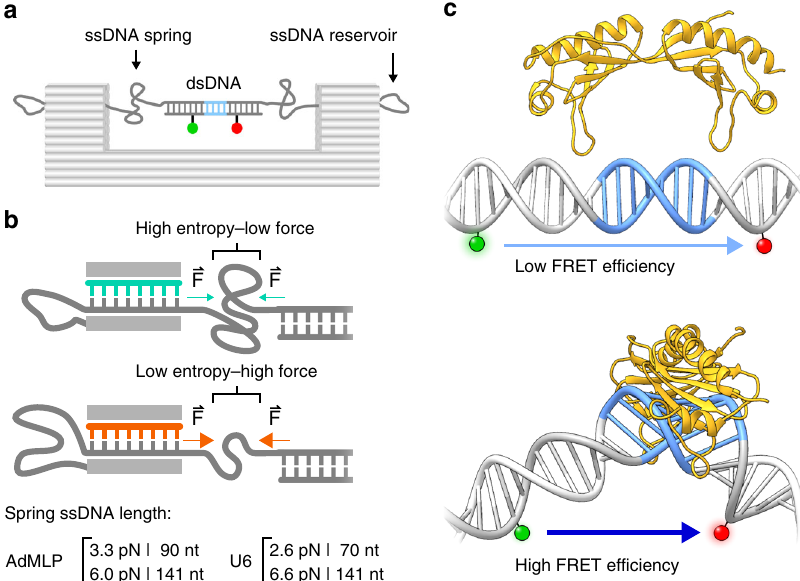
Fig. 1 DNA origami-based force clamp monitors TBP-induced DNA bending under force. a Schematic overview of the DNA origami force clamp. The ssDNA spring protrudes from the DNA origami body and spans the 43 nm gap of the rigid DNA origami clamp body (grey). Centred within the ssDNA spring is a double-stranded promoter region including the TATA-box element (blue) fl anked by a donor/acceptor (green/red) fl uorescent dye pair for FRET sensing. b The ssDNA spring length can be adjusted with DNA from the reservoir by using different staple strands (teal/orange) during assembly. Reducing the number of nucleotides spanning the gap leads to a smaller number of adoptable conformations of the ssDNA chain and thus results in a higher entropic force. The length of the ssDNA spring for low (AdMLP: 3.3 pN/U6 promoter: 2.6 pN) and high forces (AdMLP: 6.0 pN/U6 promoter: 6.6 pN) is shown. c Single-pair FRET assay as readout for the bending of promoter DNA by the TATA-binding protein (TBP, yellow). A donor (ATTO 532, green) and acceptor fl uorophore (ATTO 647 N, red) fl ank the TATA-box element (blue), resulting in a low ef fi ciency FRET between both dyes. Binding of TBP bends the DNA by ~90°, thereby decreasing the distance between the fl uorophores resulting in an increase in FRET ef fi ciency (DNA/TBP structures adapted from PDB: